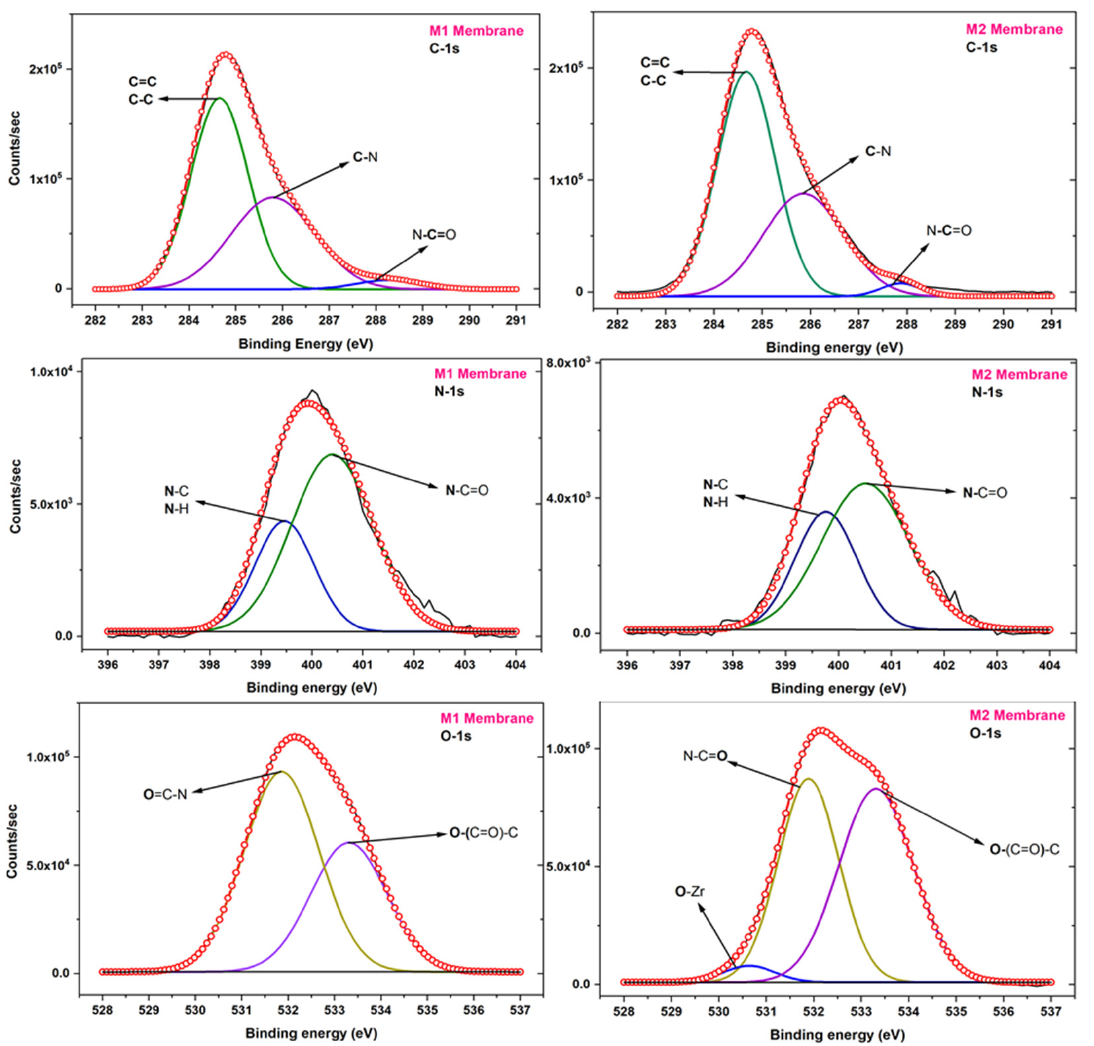
Figure 6. The high-resolution XPS plots of carbon, nitrogen and oxygen elements for M1 and M2